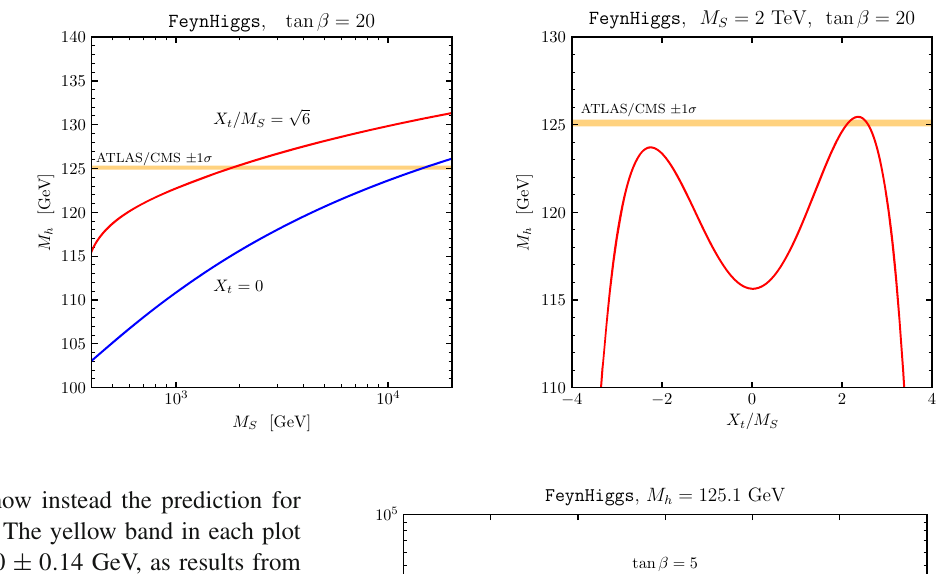
Fig. 1 The lighter CP-even Higgs mass in the MSSM as a function of a common SUSY mass parameter M S and of the stop mixing parameter X t (normalized to M S ). Both parameters are defined in the DR scheme at the scale Q = M S